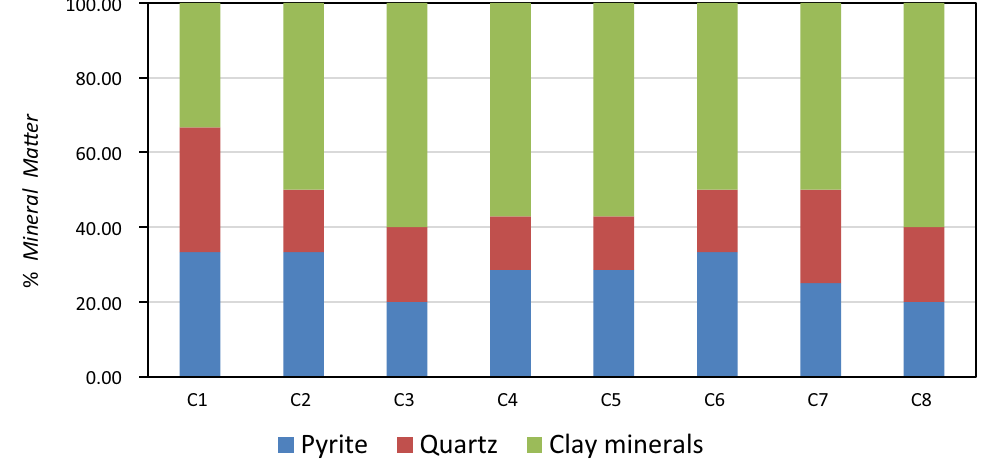
Fig. 5 Percentage mineral matter in coal samples (normalized to